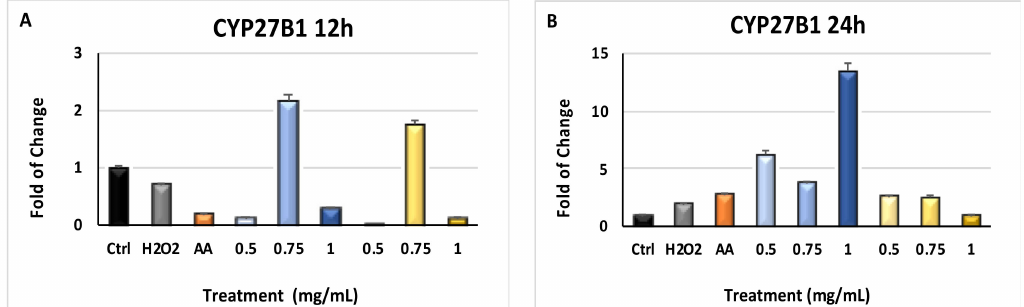
Figure 5. CYP27B1 gene expression. The expression of CYP27B1 was evaluated in cells cultured for 12 h and 24 h (Panels ( A , B )) in the presence of di ff erent concentrations of pulp and seeds extracts, and then exposed to H 2 O 2 . HFF1 were exposed to ascorbic acid (AA, orange bar), or to 0.5, 0.75 and 1 mg / mL seeds waste extracts (blue bars) or 0.5, 0.75 and 1 mg / mL pulp waste extracts (yellows bar). H 2 O 2 (grey bar) represents HFF1 cells exposed to only H 2 O 2, without previous extracts treatment. The mRNA levels for each gene was expressed as fold of change (2 yw ) of mRNA levels observed in untreated HFF1 (CTRL, black bar) defined as 1 (mean ± SD; n = 6) and normalized to Glyceraldehyde-3-Phosphate-Dehidrogenase (GAPDH). Data are represented as mean ± SD referred to the control (* p ≤ 0.05, ** p ≤ 0.01 and *** p ≤